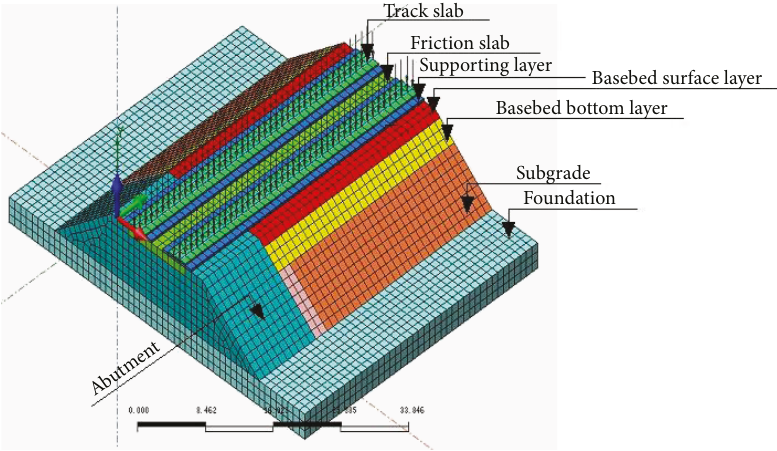
Figure 7: Numerical model of transition section.